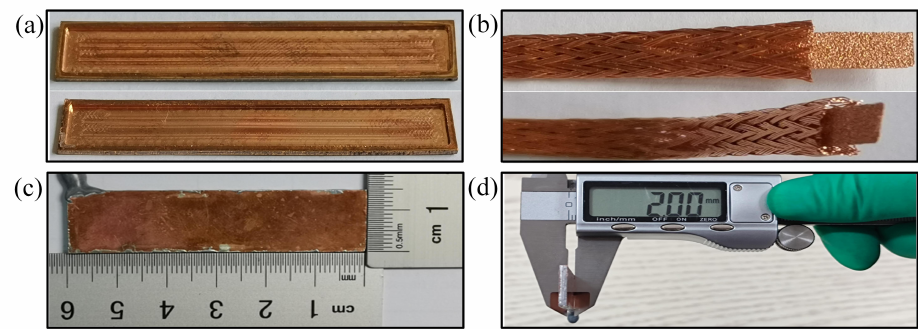
Figure 5. Shell and the composite wick. ( a ) Upper and lower shell; ( b ) Composite wick; ( c ) FMHP length and width; ( d ) FMHP